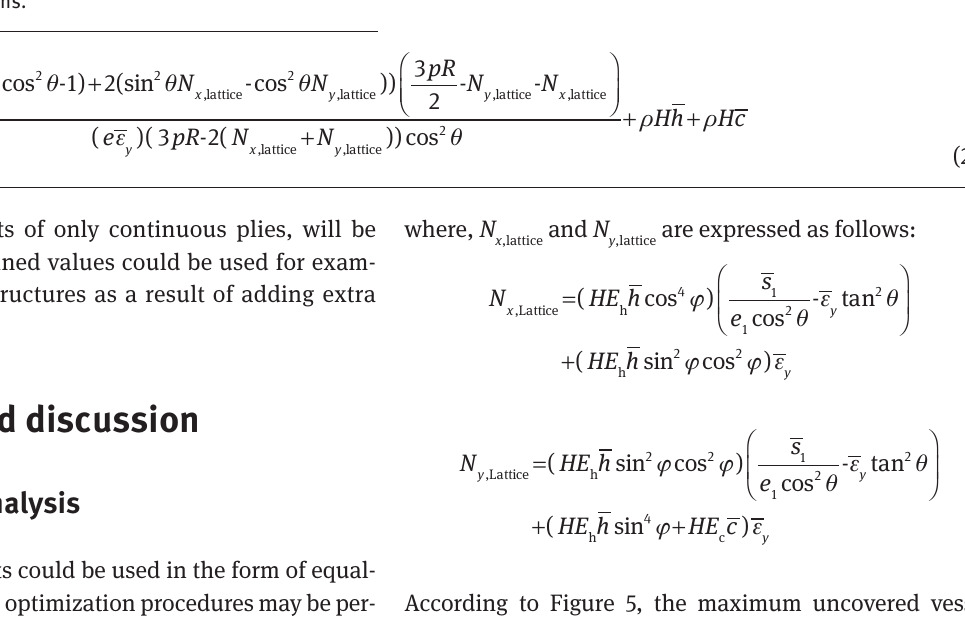
Figure 5 Dependency of uncovered vessel mass ( g able hoop and axial